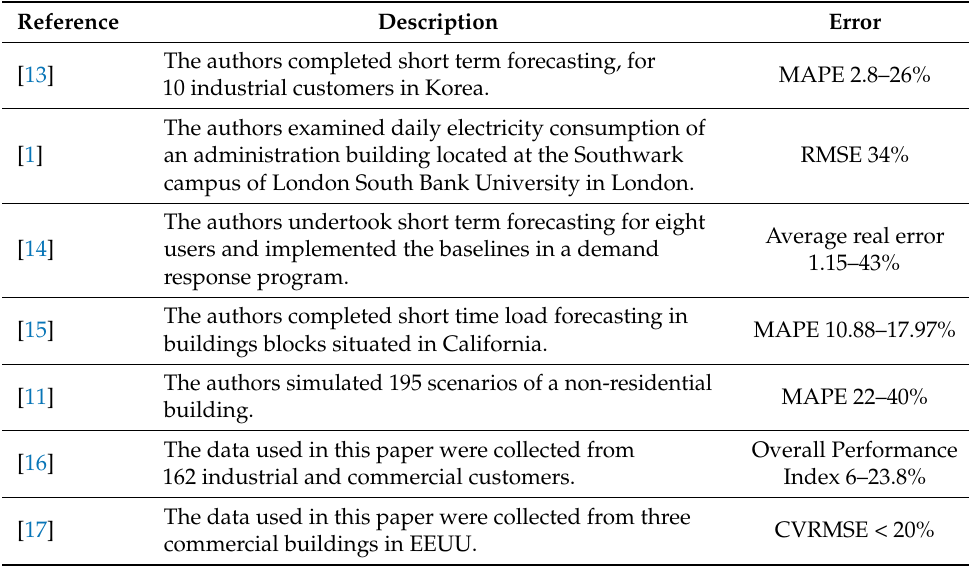
Table 1. Overview of relevant CBL prediction errors in